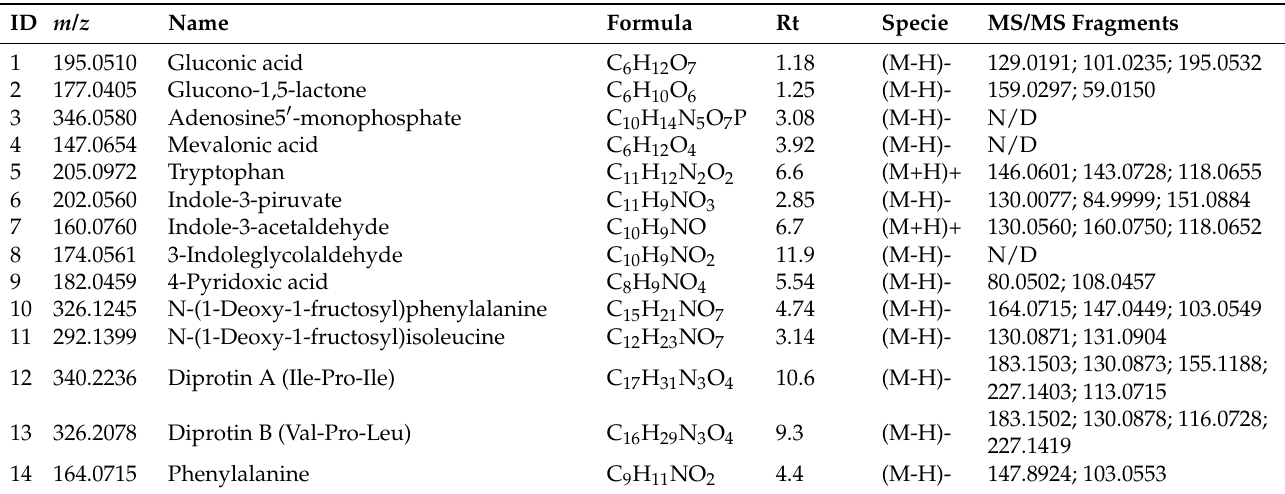
Table 3. Metabolites identified in the exo-metabolome of the bacteria.